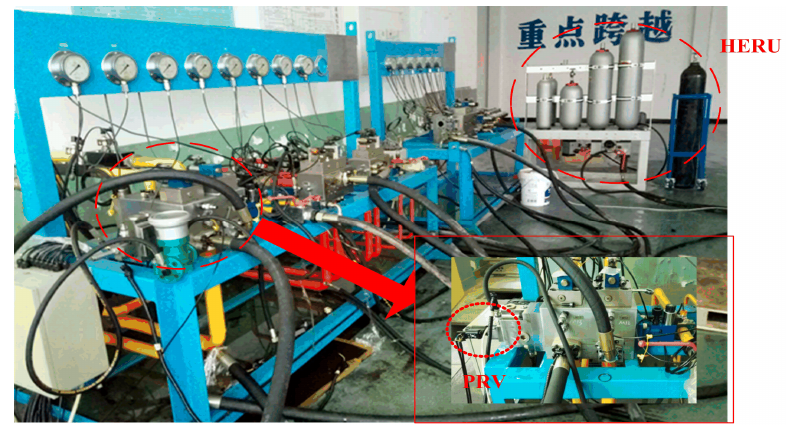
Figure 10. Layout of the tested unit.